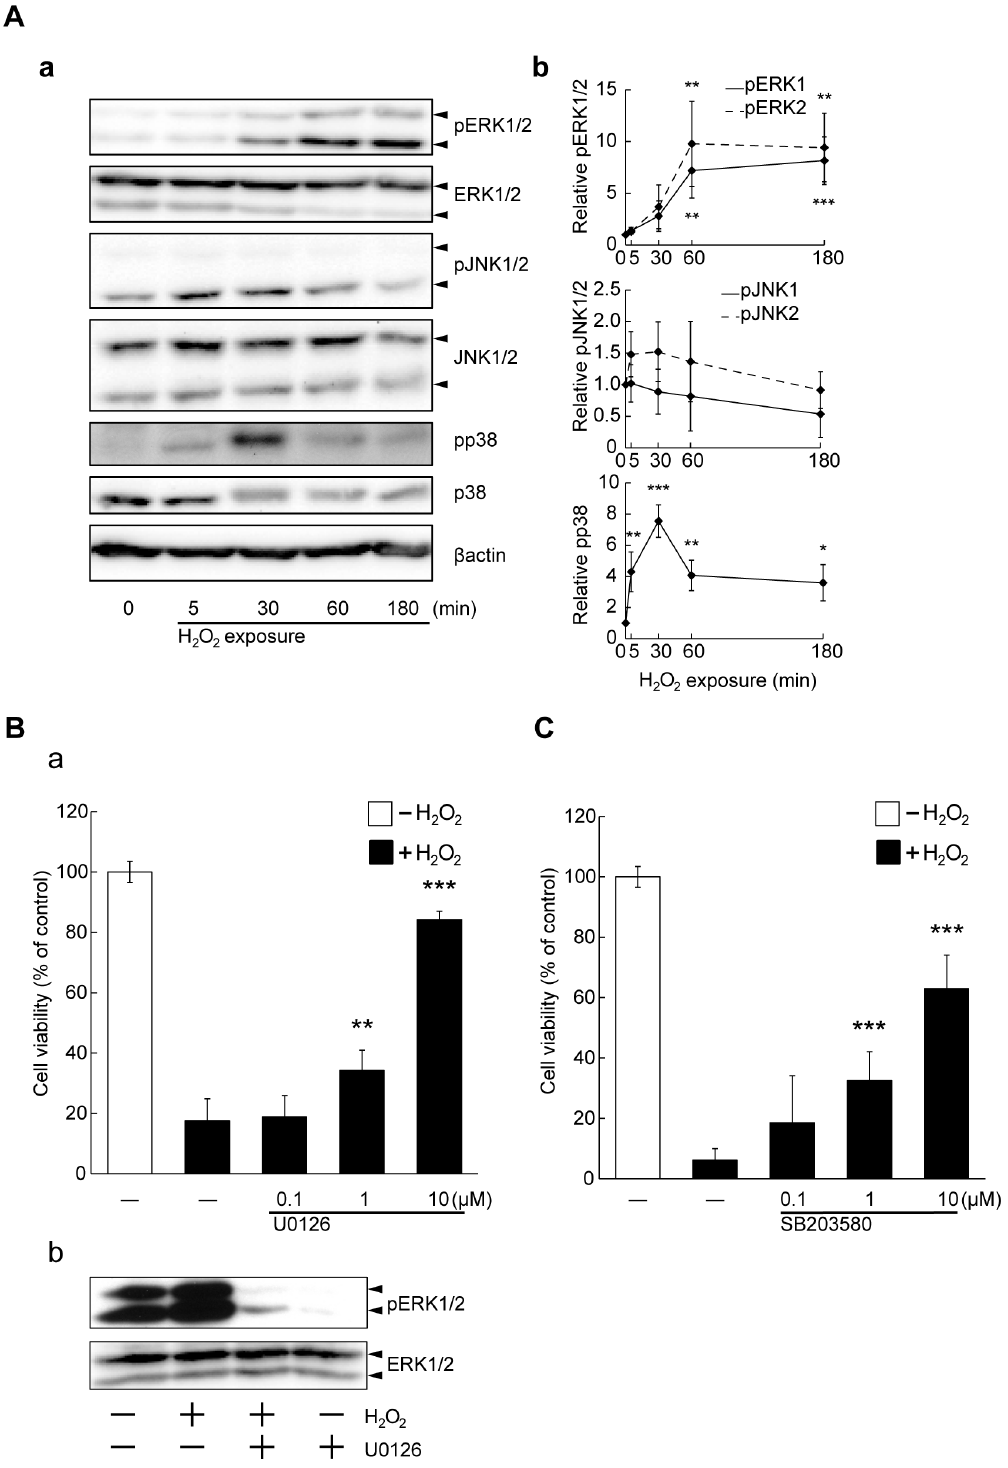
Figure 3. H 2 O 2 stimulated activation of MAPK death signaling. (A) Time-course of H 2 O 2 -induced MAPK cascades. Cortical neurons were exposed to H 2 O 2 (50 m M). a: 5, 30, 60 or 180 min later, phosphorylated ERK1/2, JNK1/2 and p38 were detected by western blotting. After that, the membranes were stripped and re-blotted with anti-total ERK1/2, JNK1/2, and p38 antibodies. b: Quantification of phosphorylated ERK1/2, JNK1/2 and p38 levels. All data represent mean 6 SD (n=4). *** P , 0.001, ** , 0.01, * , 0.05 vs. 0 min (one-way ANOVA). (B) a: U0126, an ERK signal inhibitor, suppressed H 2 O 2 -induced neuronal cell death in a dose-dependent manner. U0126 was added at 0.1, 1, or 10 m M. After 20 min, H 2 O 2 application was performed, followed by MTT assay. The data represent mean 6 SD (n=4). *** P , 0.001, ** , 0.01 vs. + H 2 O 2 - U0126 (two-way ANOVA). b: U0126 suppressed phosphorylation of ERK1/2. U0126 was added at 10 m M. After 20 min, cortical neurons were exposed to H 2 O 2 (50 m M) for 1 hour. After pERK1/2 was detected by western blotting, the membranes were stripped and re-blotted with anti-total ERK1/2 antibody. (C) SB203580, a p38